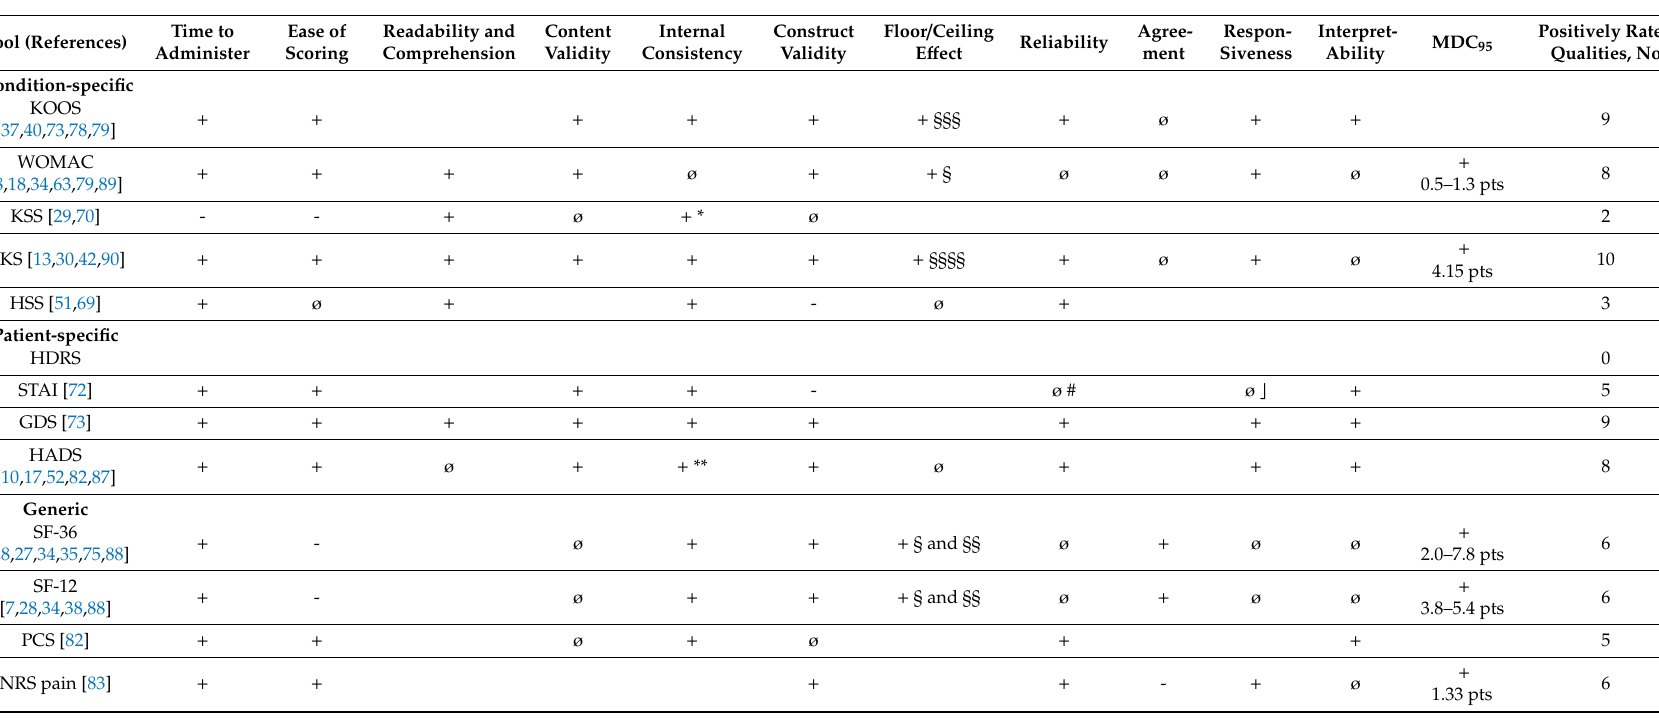
Table A4. Summary of the quality assessment of the patient-reported outcome measures included.